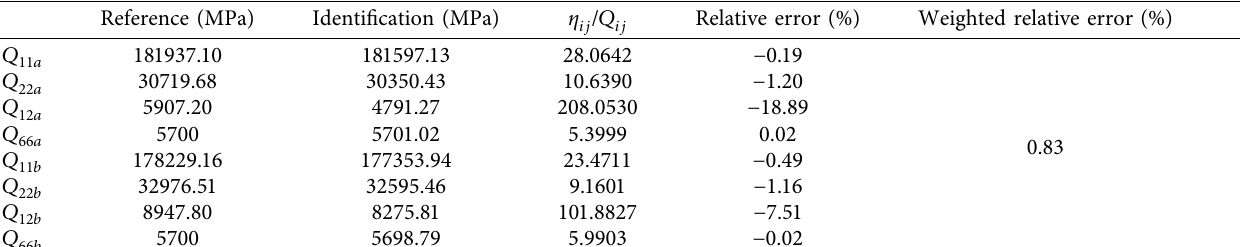
Table 3: Identification results of constitutive parameters of orthotropic bimaterial using the optimized polynomial virtual fields. Reference